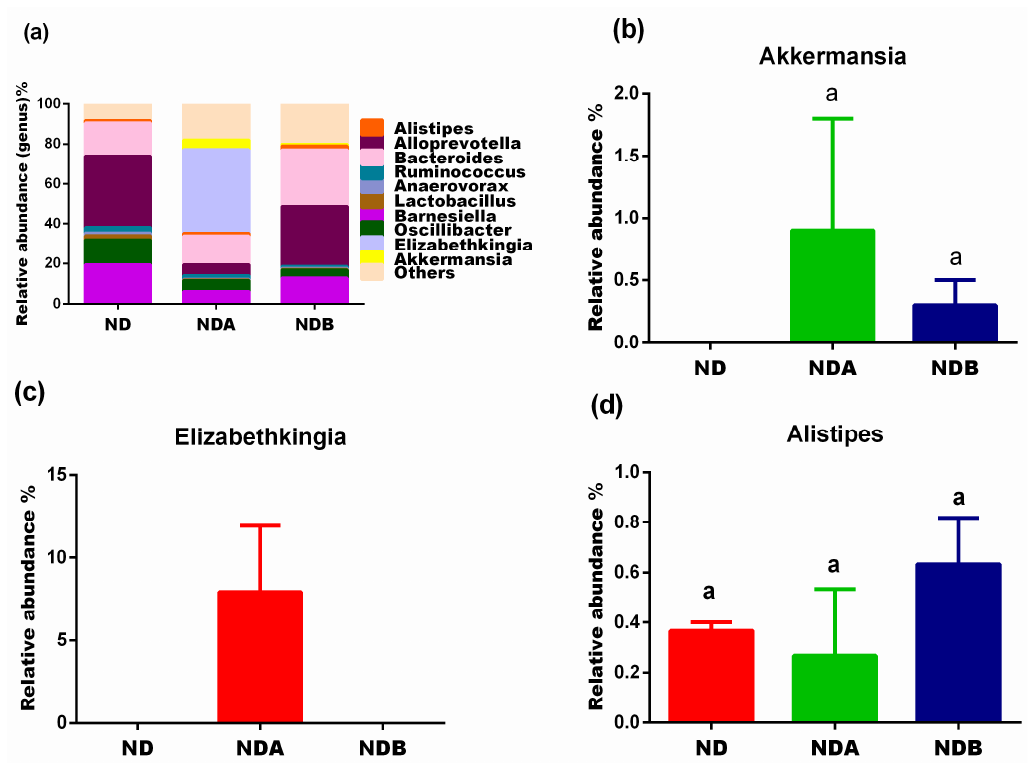
Figure 7. Effects of urolithins on gut microbial composition at the genus level. Relative abundance at the genus level ( a ), relative levels of Akkermansia ( b ), relative levels of Elizabethkingia ( c ), relative levels of Alistipes ( d ). a Data are expressed as mean ± SE. Mean values bearing different letters are significantly different ( p < 0.05).